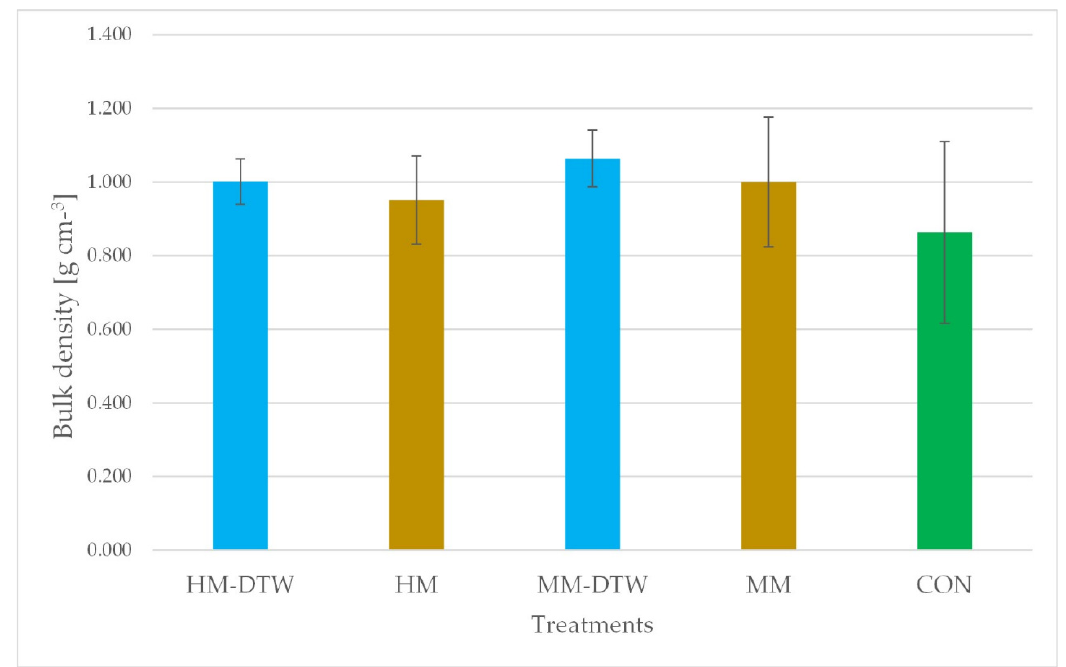
Figure 2. Bulk density for the different treatments. Obtained p -value from ANOVA was p = 0.37 (HM-DTW—areas identified as sensitive by DTW algorithm and harvested with high mechanisation level; HM—areas not identified as sensitive by DTW algorithm and harvested with high mechanisation level; MM-DTW—areas identified as sensitive by DTW algorithm and harvested with medium mechanisation level; MM—areas not identified as sensitive by DTW algorithm and harvested with medium mechanisation level; CON—control area consisting of unharvested oak coppice in the last 20 years located close to the two parcels).